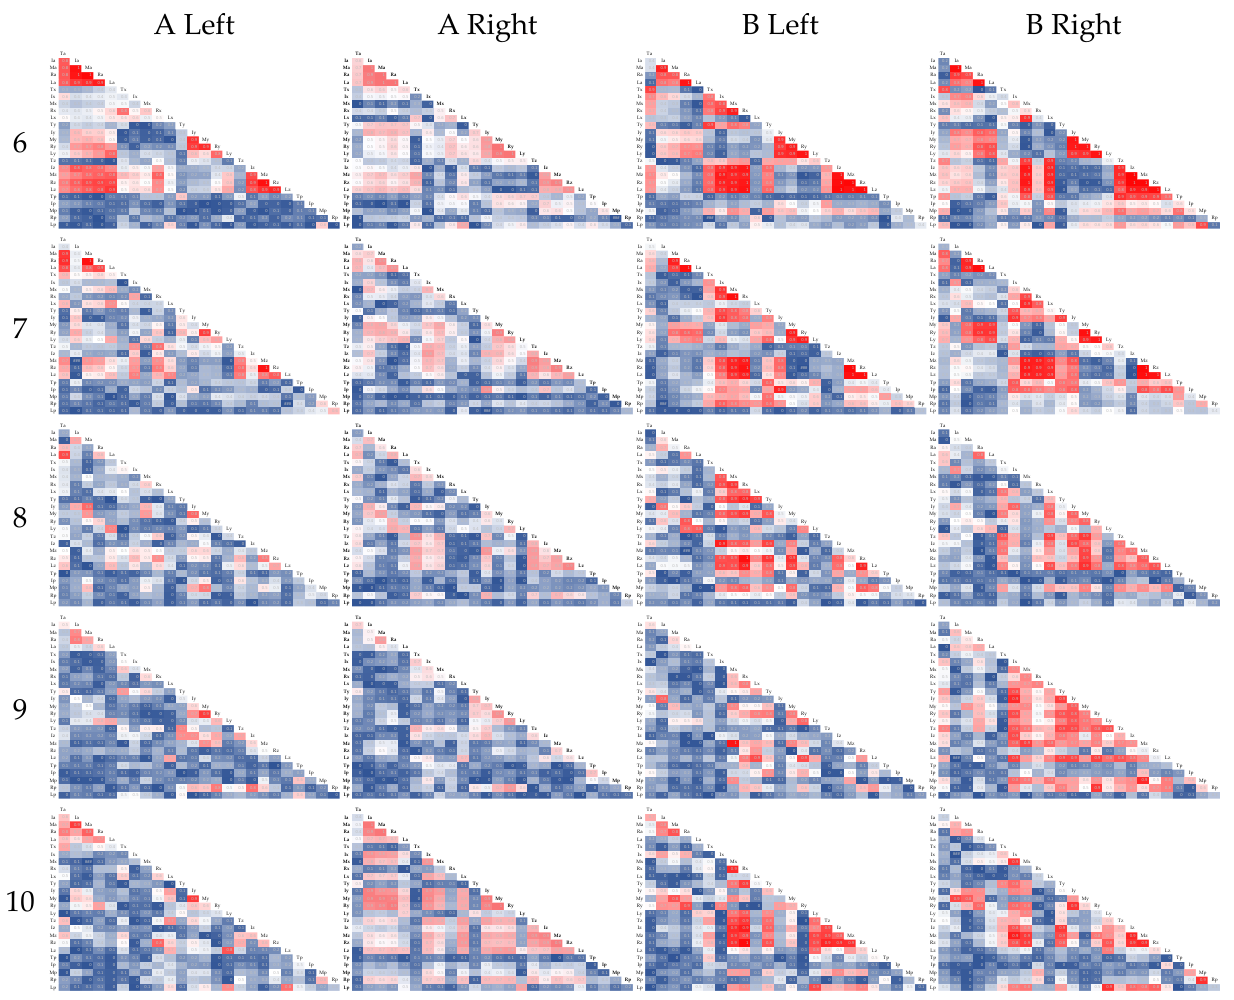
Figure 8. Correlation coefficient after condition